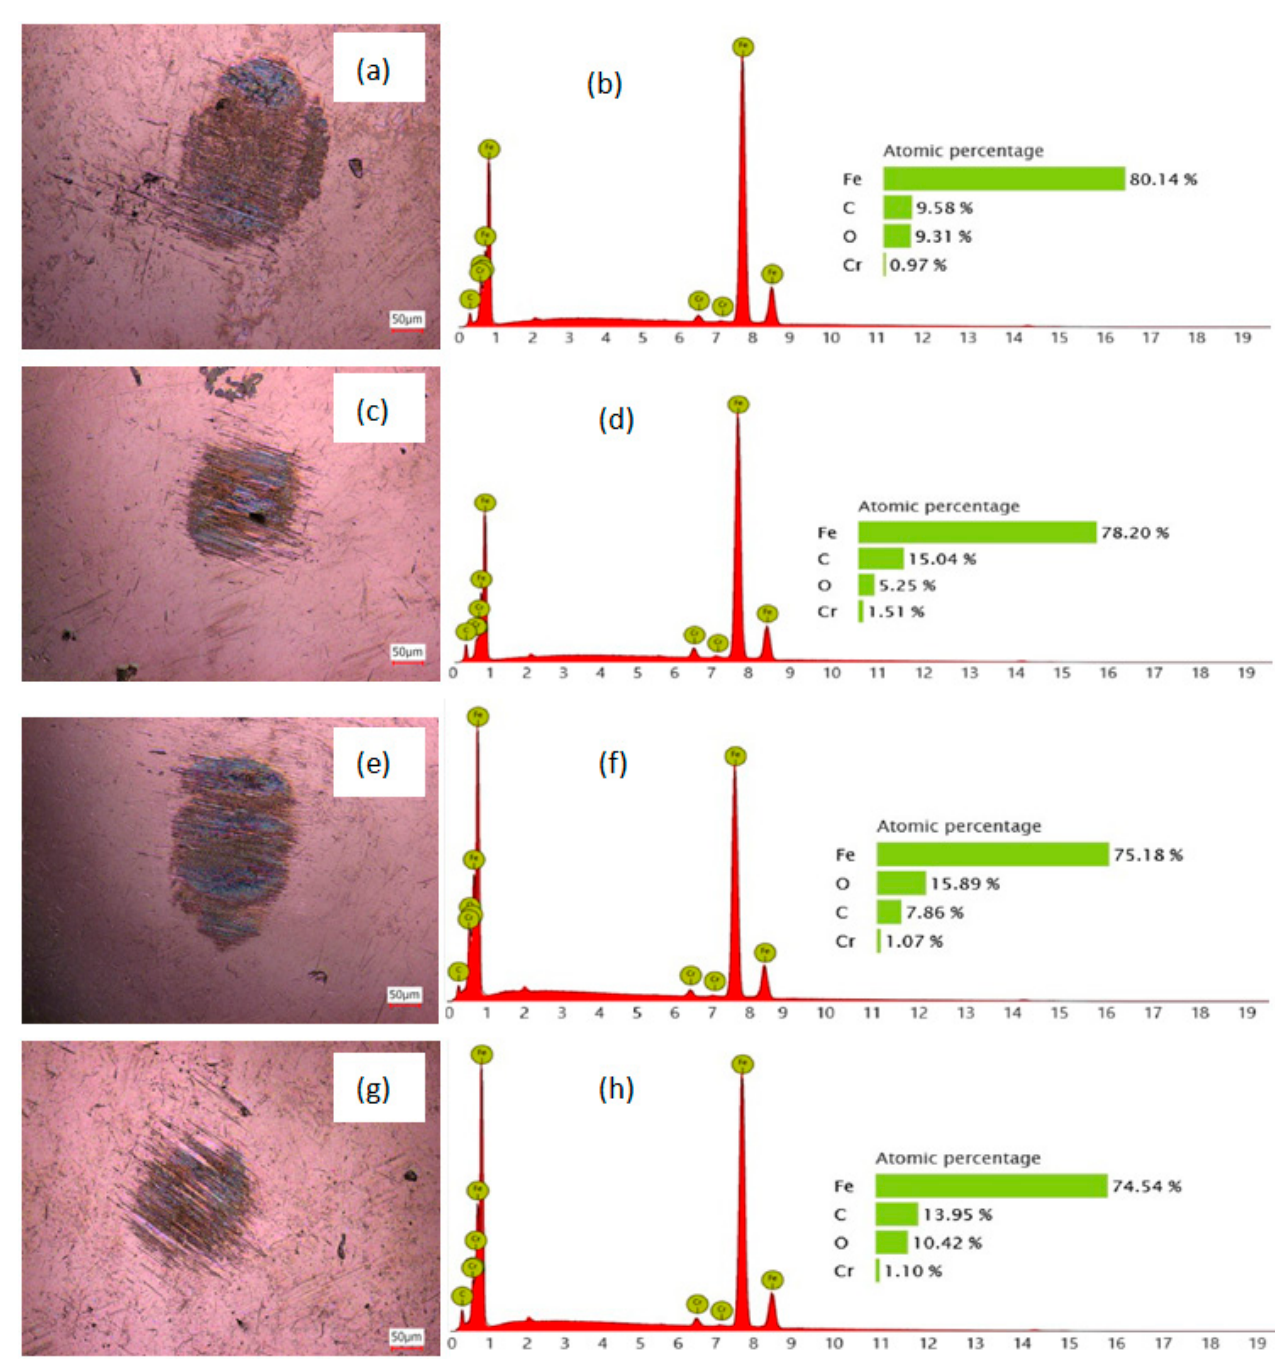
Figure 11. The optical micrograph of steel ball worn surfaces of friction pair and energy-dispersive spectroscopy (EDS) patters of the steel disc worn surfaces of friction pair. ( a , b ) Lubricated by oil sample 1; ( c , d ) lubricated by oil sample 1 with 0.03 wt % graphene additives; ( e , f ) lubricated by oil sample 2; ( g , h ) lubricated by oil sample 2 with 0.03 wt % graphene additives.